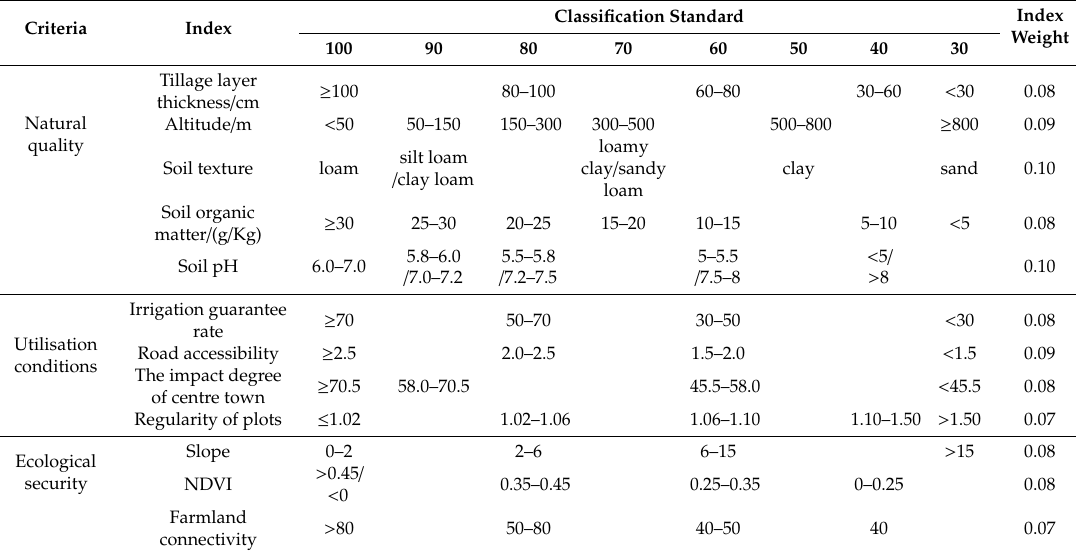
Table 1. Comprehensive evaluation indicator system and quantification standards of cultivated land